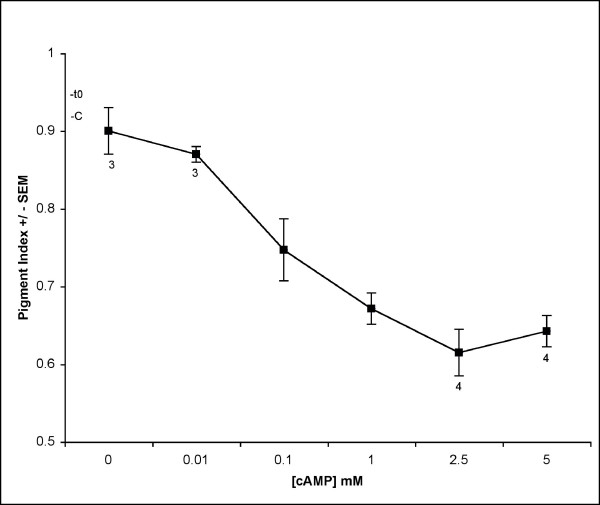
Dose response analysis of cyclic AMP's effects on pigment granule aggregation in isolated RPE cells. The t0 PI was 0.95 ± 0.02 (n = 7) after a 30 minute preculture. RPE cells were cultured in cAMP for 30 minutes. The control PI was 0.91 ± 0.02 n = 7, except where noted.